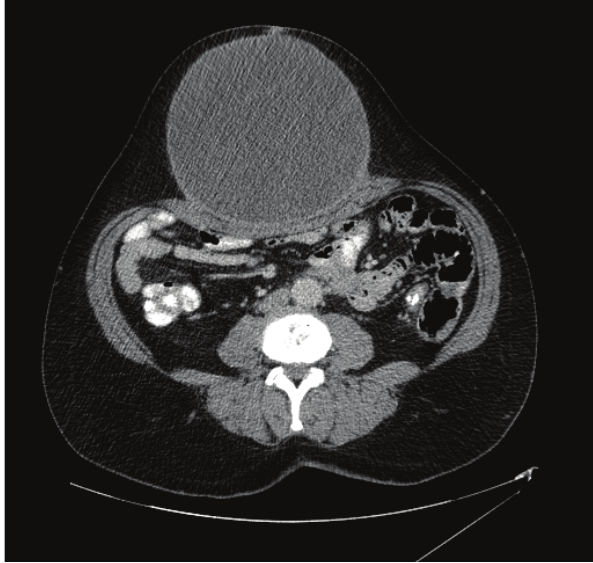
Figure 2: Giant cystic lesion on the computed tomography